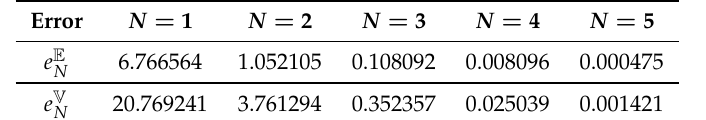
V , given by (36) for N